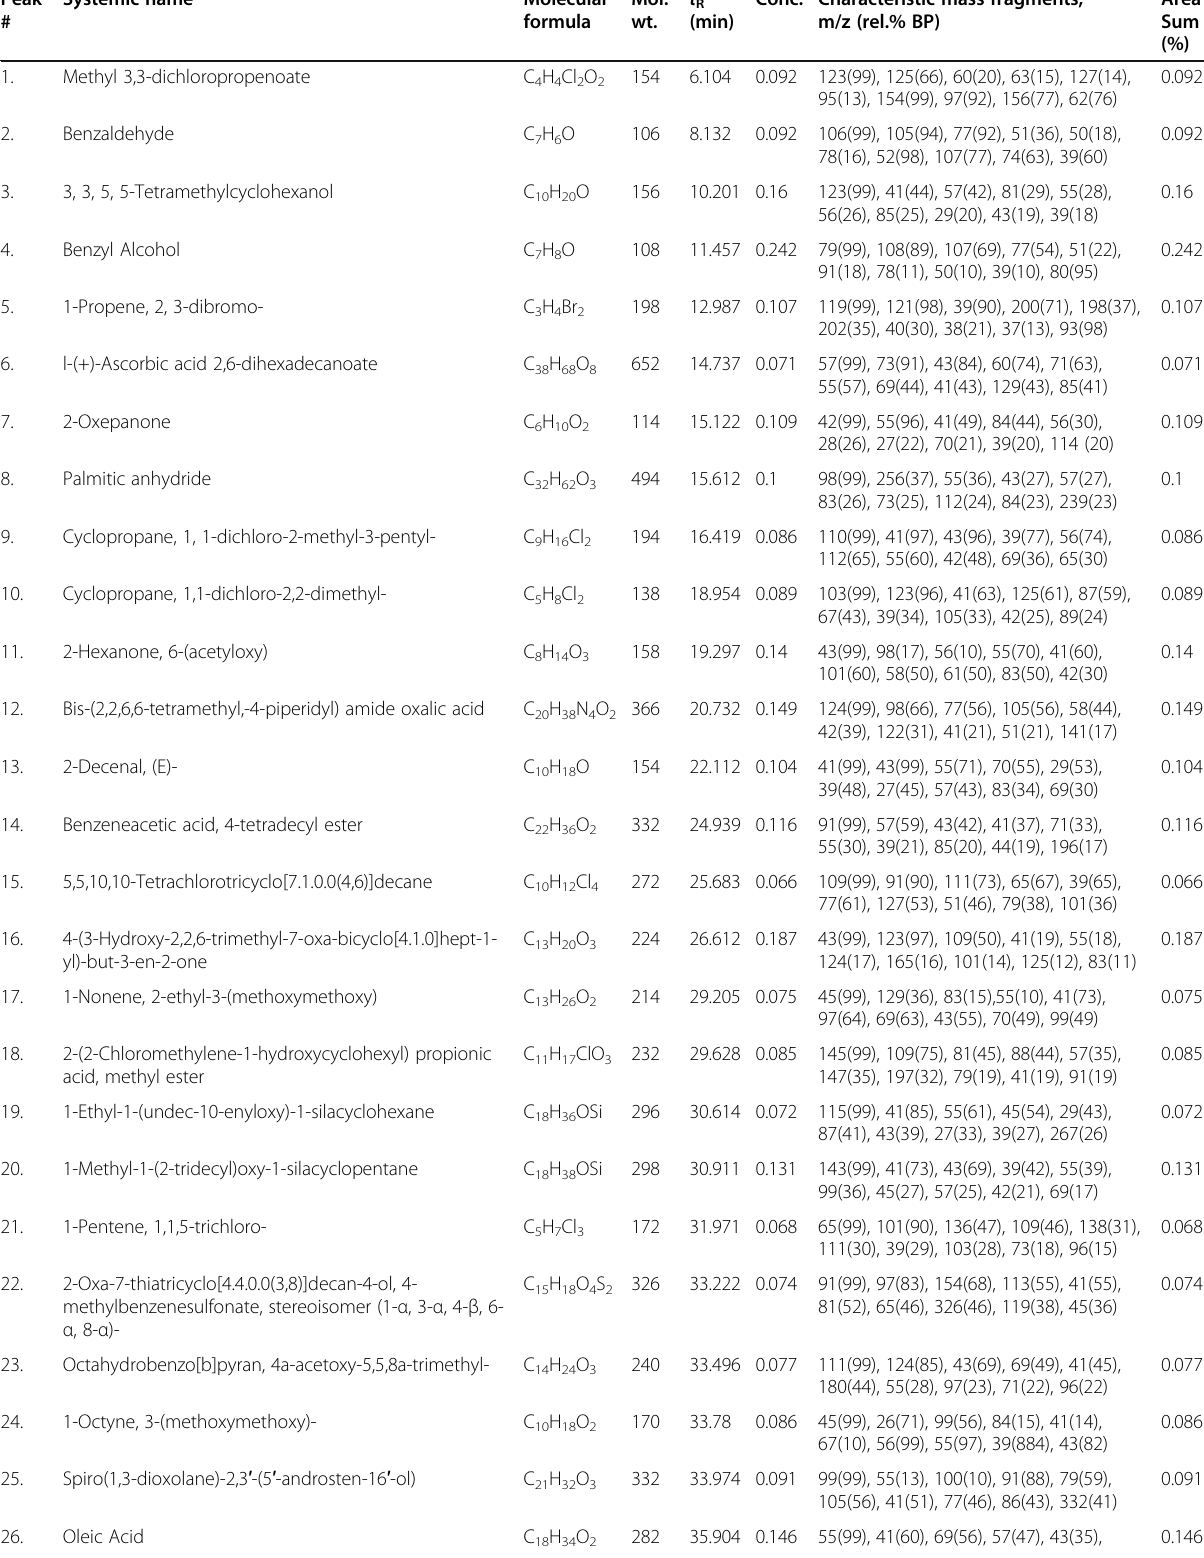
Table 5 Spectral data of n -hexane soluble fraction of Sargassum